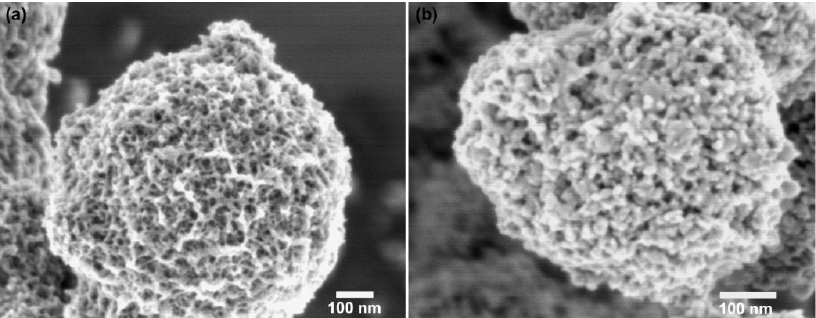
Fig. 3 SEM images of the CoSe 2 samples synthesized at different hydrothermal reaction temperatures: (a) 160 ℃ (Sample B) and (b) 200 ℃ (Sample D).